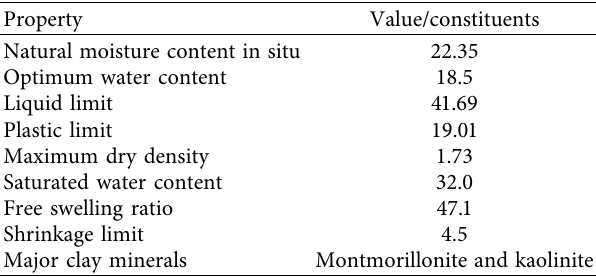
Table 1: Geotechnical and physical properties of the test soil.